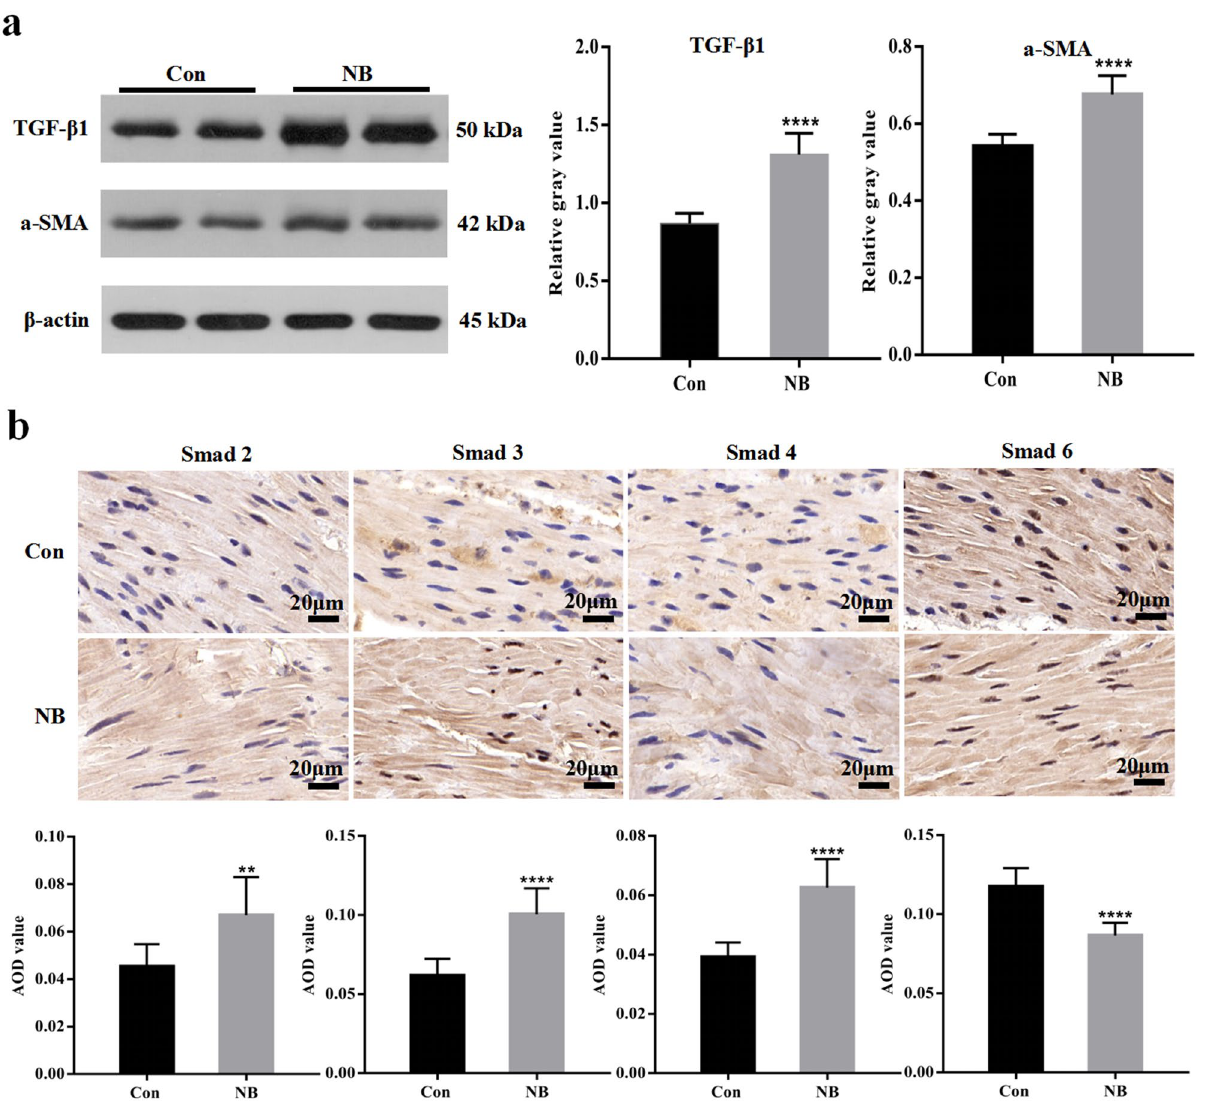
Figure 1. Expression of TGF-β1, Smad2, Smad3, Smad4, Smad6 and α-SMA in the NB and control groups: ( a ) Western blot analysis of TGF-β1 and α-SMA. The gray value ratios of TGF-β1 and α-SMA to β-actin between the two groups were compared. Representative western blots were cropped from the same blots. Original blots are presented in Supplementary material. ( b ) Immunohistochemical staining of Smad2, Smad3, Smad4, and Smad6. The brownish-yellow area in the figure indicates that positive staining for the target protein. The AOD values of each Smad protein were compared between the two groups. The bars indicate 20 μm. The data are shown as the means ± SD. ** p < 0.01; *** p < 0.001; **** p < 0.0001 versus the control. Student’s t test. AOD, average optical